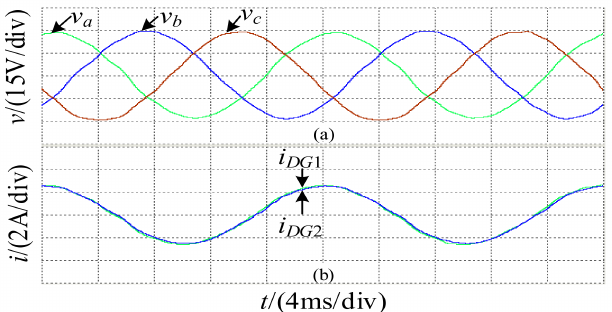
Figure 11. The experimental results of the traditional control method under the unbalanced load connected to the PCC: ( a ) PCC voltage; ( b ) Phase A output current of DGs.